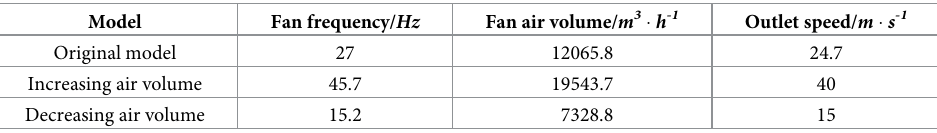
Table 2. Different negative pressure fan parameters and outlet